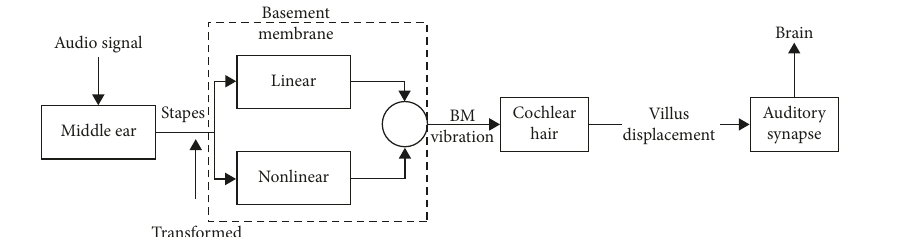
Figure 1: Structure of human auditory model.